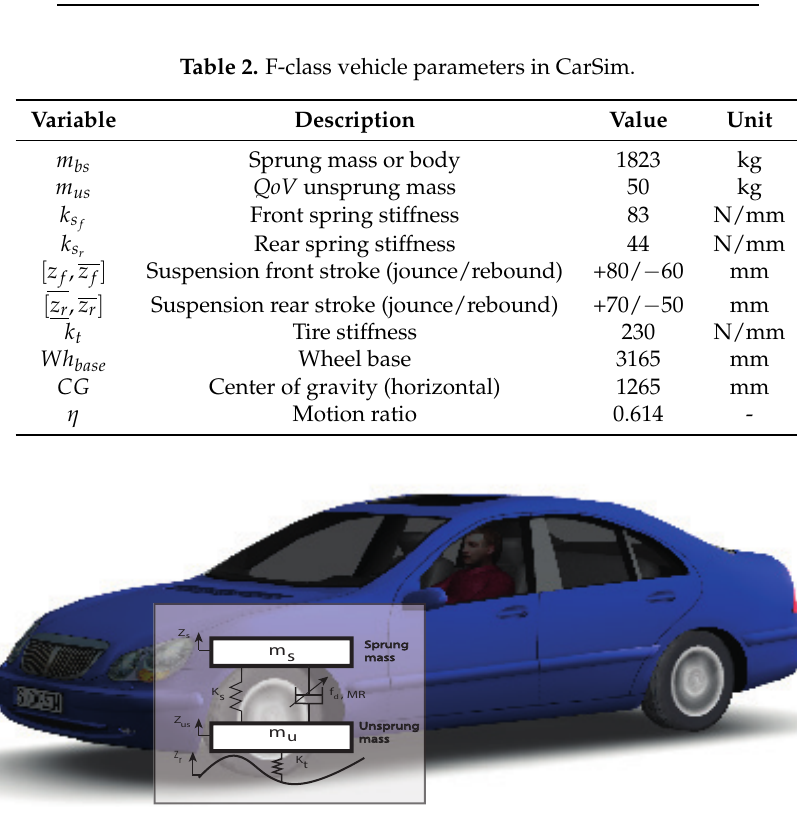
Figure 2. F-class vehicle, adapted from